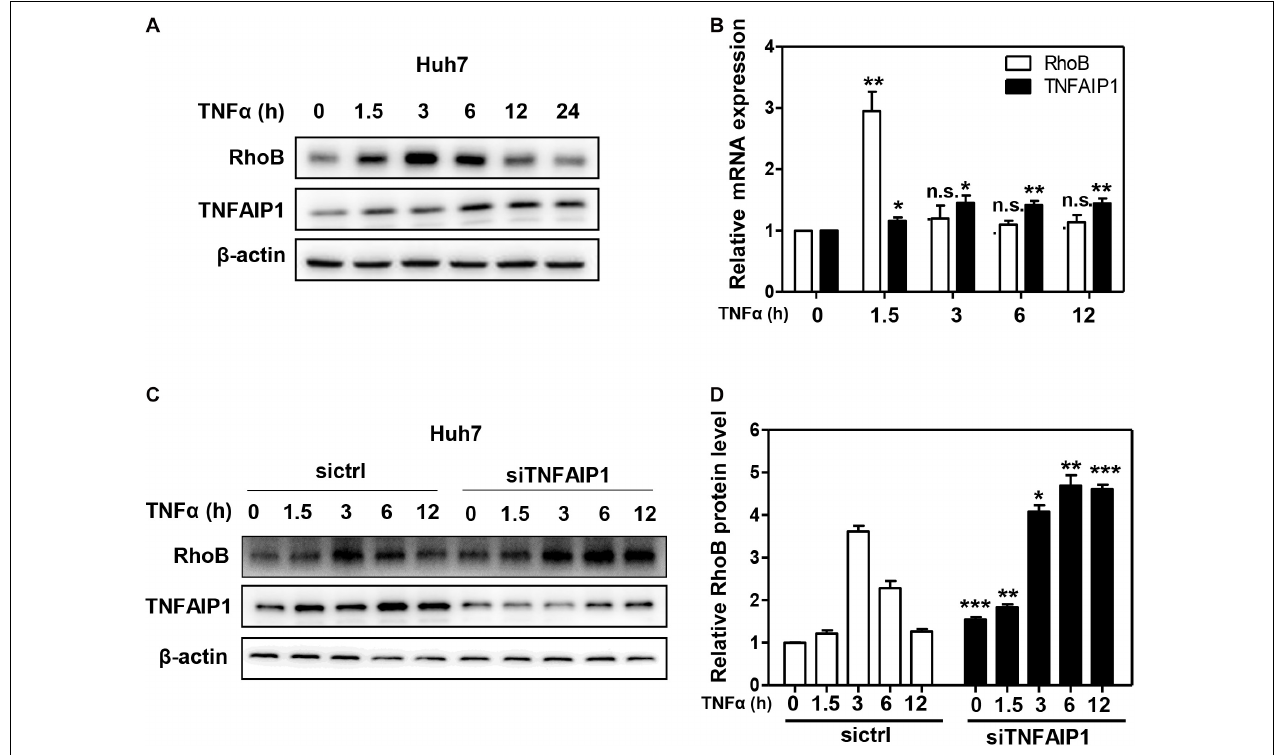
FIGURE 5 | The turnover of RhoB upon TNF α stimulation is regulated by TNFAIP1. (A) Time course of induction of TNFAIP1 and RhoB protein levels upon TNF α treatment in Huh7 cells. Huh7 cells were treated with 20 ng/mL TNF α at indicated time and determined the protein levels of RhoB and TNFAIP1 by western blot analysis with β -actin as a loading control. (B) Time course of induction of TNFAIP1 and RhoB transcripts upon TNF α treatment in Huh7 cells. Huh7 cells were treated with 20 ng/mL TNF α at indicated time and determined the transcriptional levels of RhoB and TNFAIP1 by qPCR analysis. (C) Silencing TNFAIP1 extended the half-life of RhoB in Huh7 cells upon TNF α treatment. Huh7 cells were treated with 20 ng/mL TNF α at indicated time and western blot was used to analyze the RhoB protein levels upon TNFAIP1 knockdown via siRNA silencing with β -actin as a loading control. (D) The protein levels were quantified by densitometric analysis and statistical analysis was performed. * P < 0.05, ** P < 0.01, and *** P < 0.001 vs. control group; n.s. = not